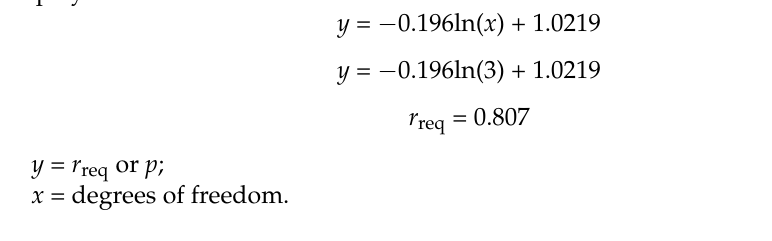
Table 1. Table of correlation coefficients at varying degrees of